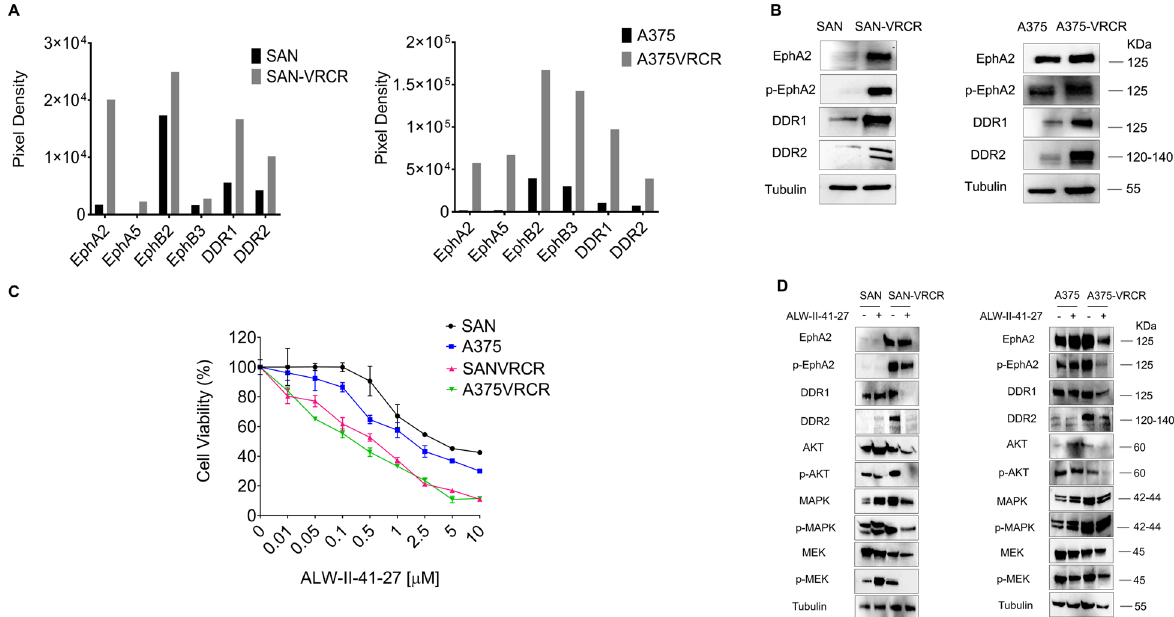
Fig. 3 Expression and activation of receptor tyrosine kinases (RTK) and sensitivity to ALW-II-41-27inhibitor in parental and resistant melanoma cell lines. A Cell lysates of SAN, SAN-VRCR, A375 and A375-VRCR cell lines were analyzed using the TKR array kit. The graph represents quantification of mean pixel density using ImageJ program. B Western blot analysis of EphA2, DDR1 and DDR2 proteins in basal condition of melanoma cancer cell lines. Tubulin was used as a loading control. C Cell viability was evaluated by MTT staining on parental (SAN and A375) and resistant (SAN-VRCR and A375-VRCR) cell lines following treatment for 72 h with increasing concentrations of ALW-II-41-27inhibitor (range 0,01–10 µM). D Western blot analysis of EphA2, DDR1, DDR2, AKT, MAPK and MEK proteins in all cell lines untreated and treated with ALW-II-41-27 inhibitor (0,5